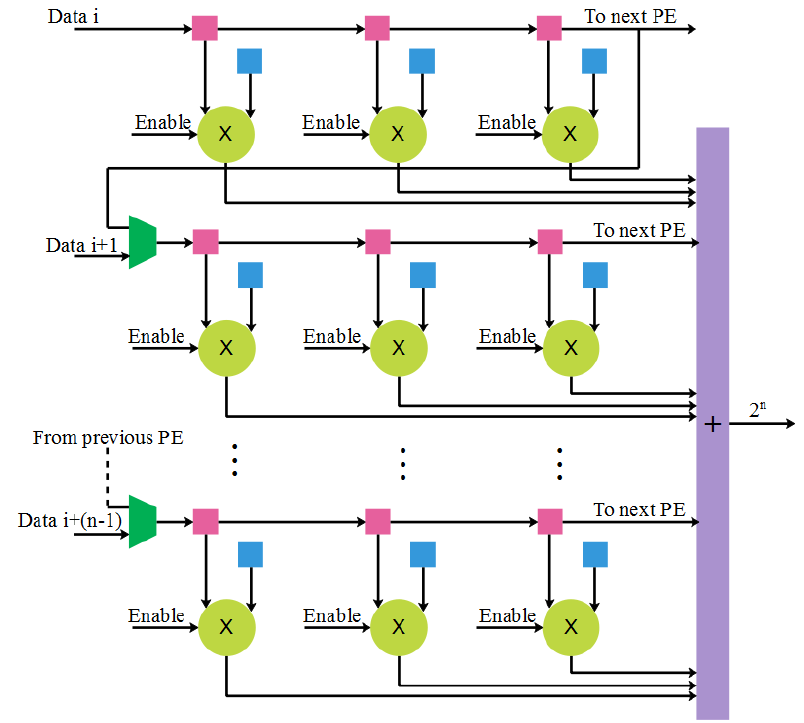
Figure 2. Architecture of reconfigurable PE.